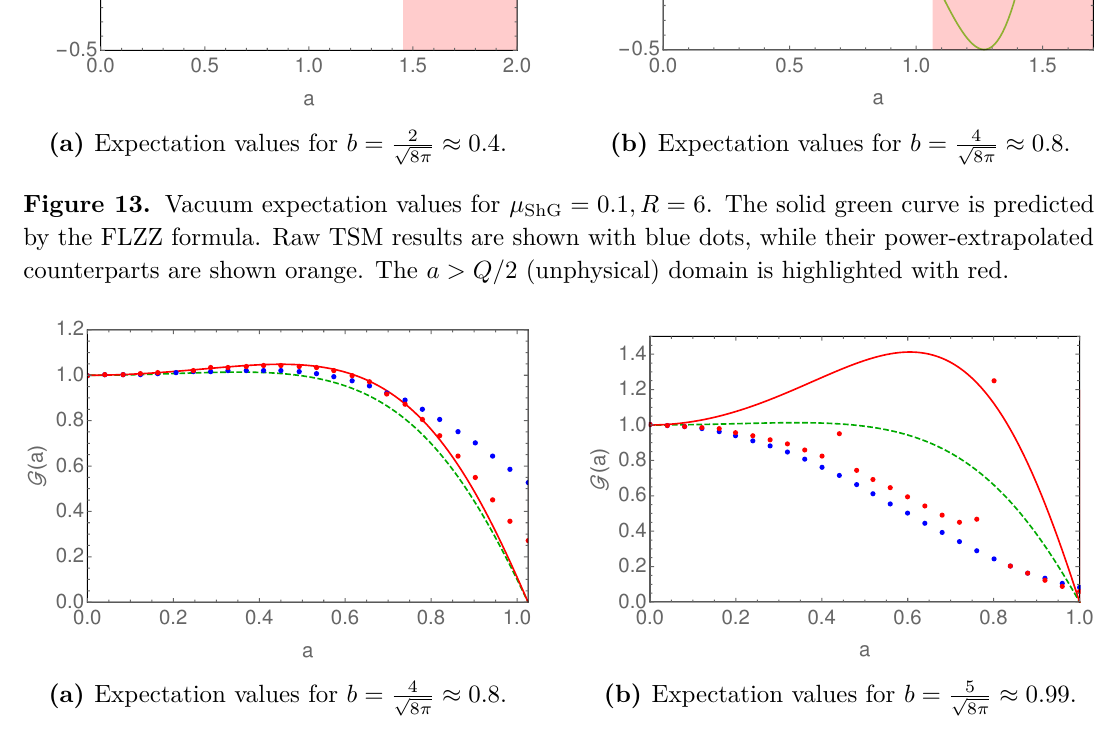
Figure 14. Vacuum expectation values for µ ShG = 0 . 1 , R = 2 . Raw TSM results are shown with blue dots, while their power-extrapolated counterparts are depicted with red dots. The R → ∞ theoretical value of the VEV is plotted as a dashed green line. The finite volume corrected version involving up to 2nd order terms in the Leclair-Mussardo series is shown as a red solid